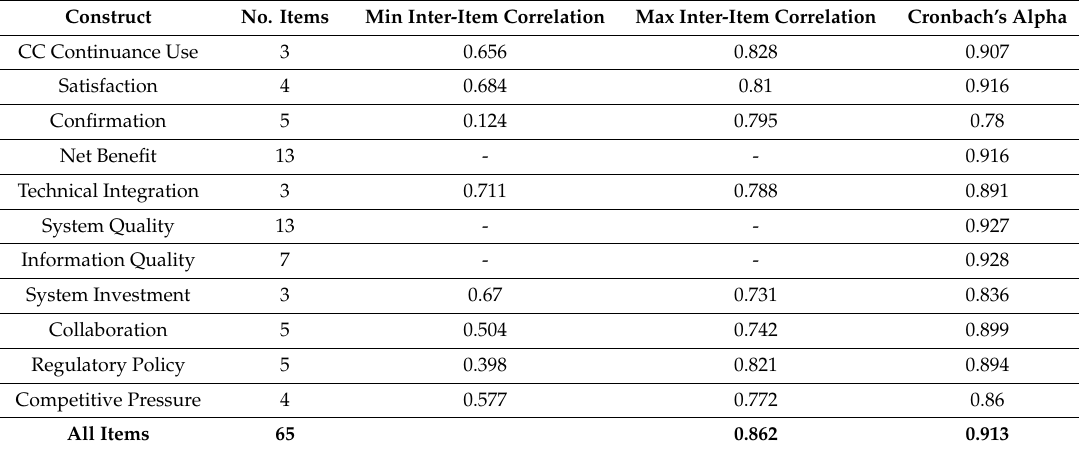
Table 5. Reliability